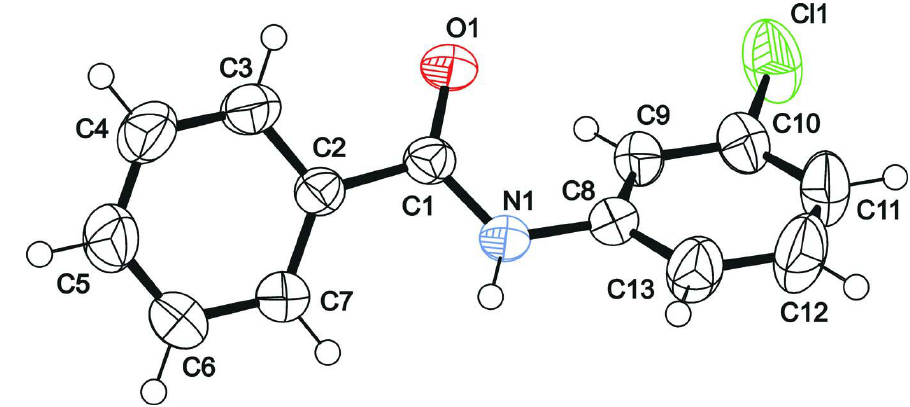
Figure 1 Molecular structure of the title compound showing the atom labelling scheme. Displacement ellipsoids are drawn at the 50% probability level. H atoms are represented as small spheres of arbitrary radii.